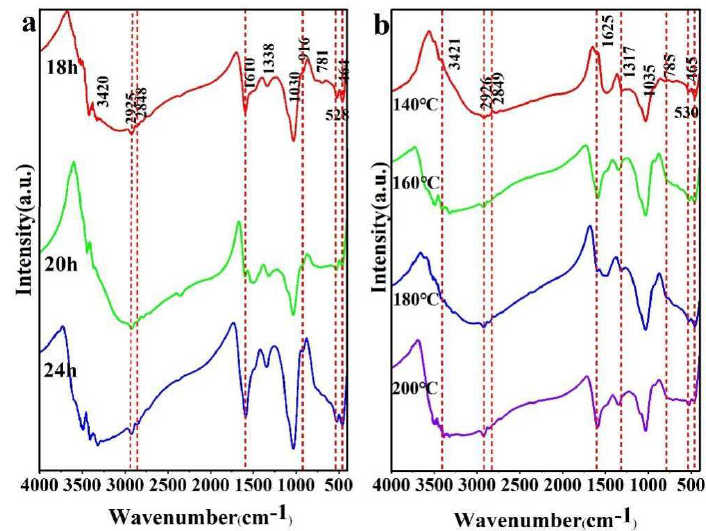
Figure 6. Fourier transform infrared spectra of TiO 2 -montmorillonite (MMT) composites prepared using ( a ) different dwelling times at a reaction temperature of 160 °C, a pH of 6, and a TiO 2 mass ratio of 30 wt% and ( b ) different reaction temperatures at a dwelling time of 24 h, a pH of 6, and a TiO 2 mass ratio of 30 wt%.